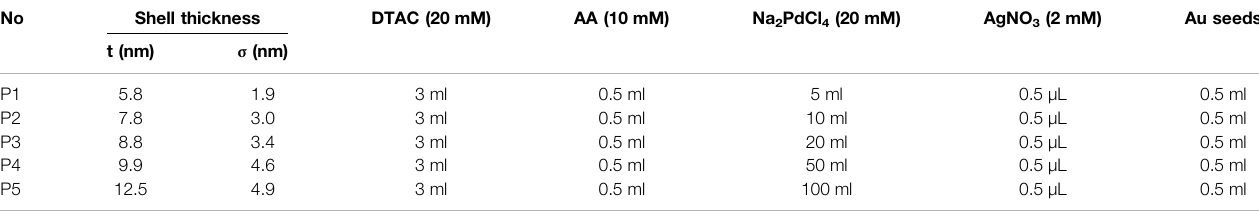
TABLE 1 | Size information and synthetic parameters for Au@PdAg concave nanocubes with controlled thickness.